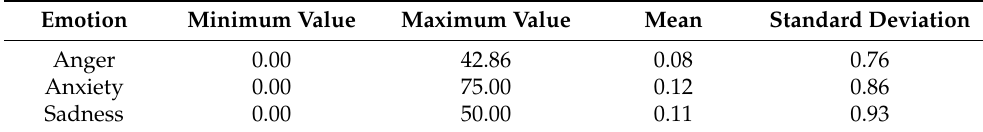
Table 3. Descriptive statistics of emotions. Emotion Minimum Value Maximum Value Mean Standard Deviation Anger Anxiety